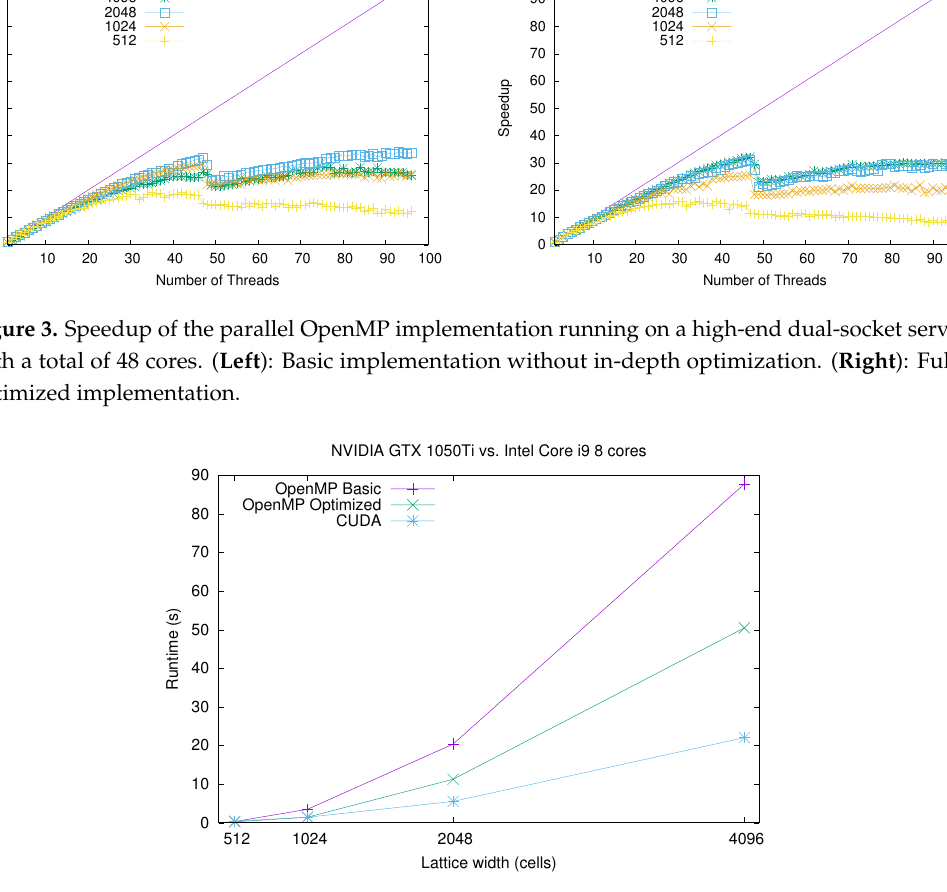
Figure 4. Runtime comparison between NVIDIA GTX 1050 Ti GPU and Intel Core i9 (eight cores) for different CA lattice